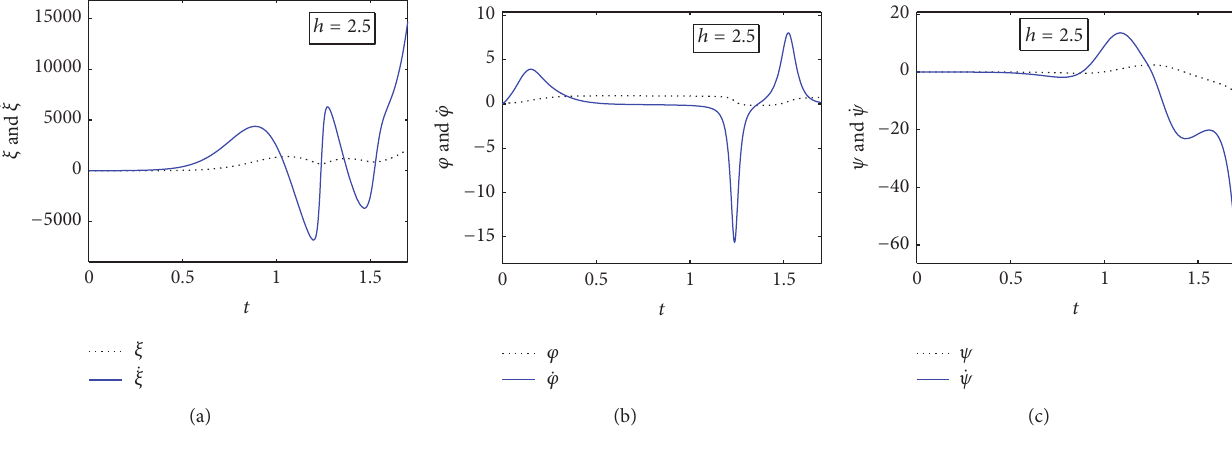
Figure 9: (a), (b), and (c) demonstrate the variation of ( 𝜉 and 𝑎 = 0.5 m, and 𝜑 = 0.4 0